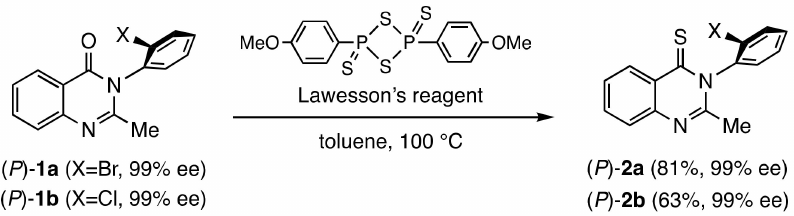
Figure 1. N-C axially chiral mebroqualone 1a and the intermolecular halogen bond (C=O · · · Br) ob- served in the crystal of racemic 1a